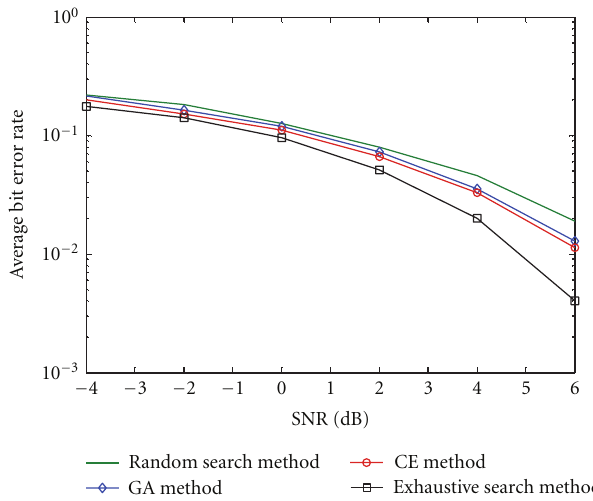
Figure 4: Average BER versus SNR for di ff erent